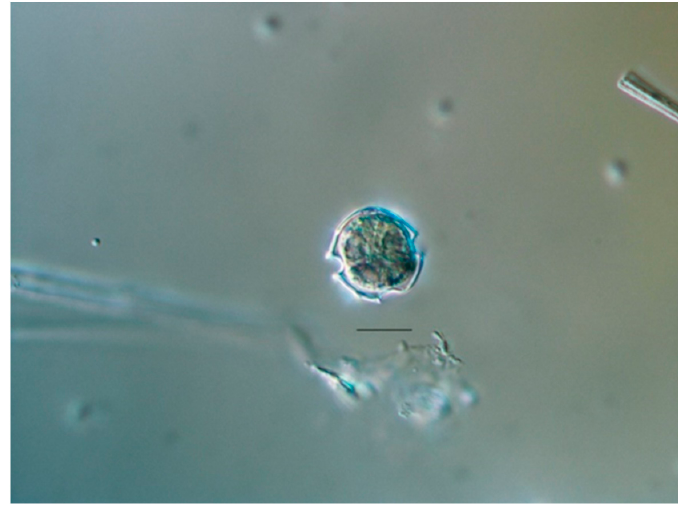
Figure 2. Optical microscope photograph of Alexandrium minutum identified in Sardinia in 2021 (scale bar 10 µm).